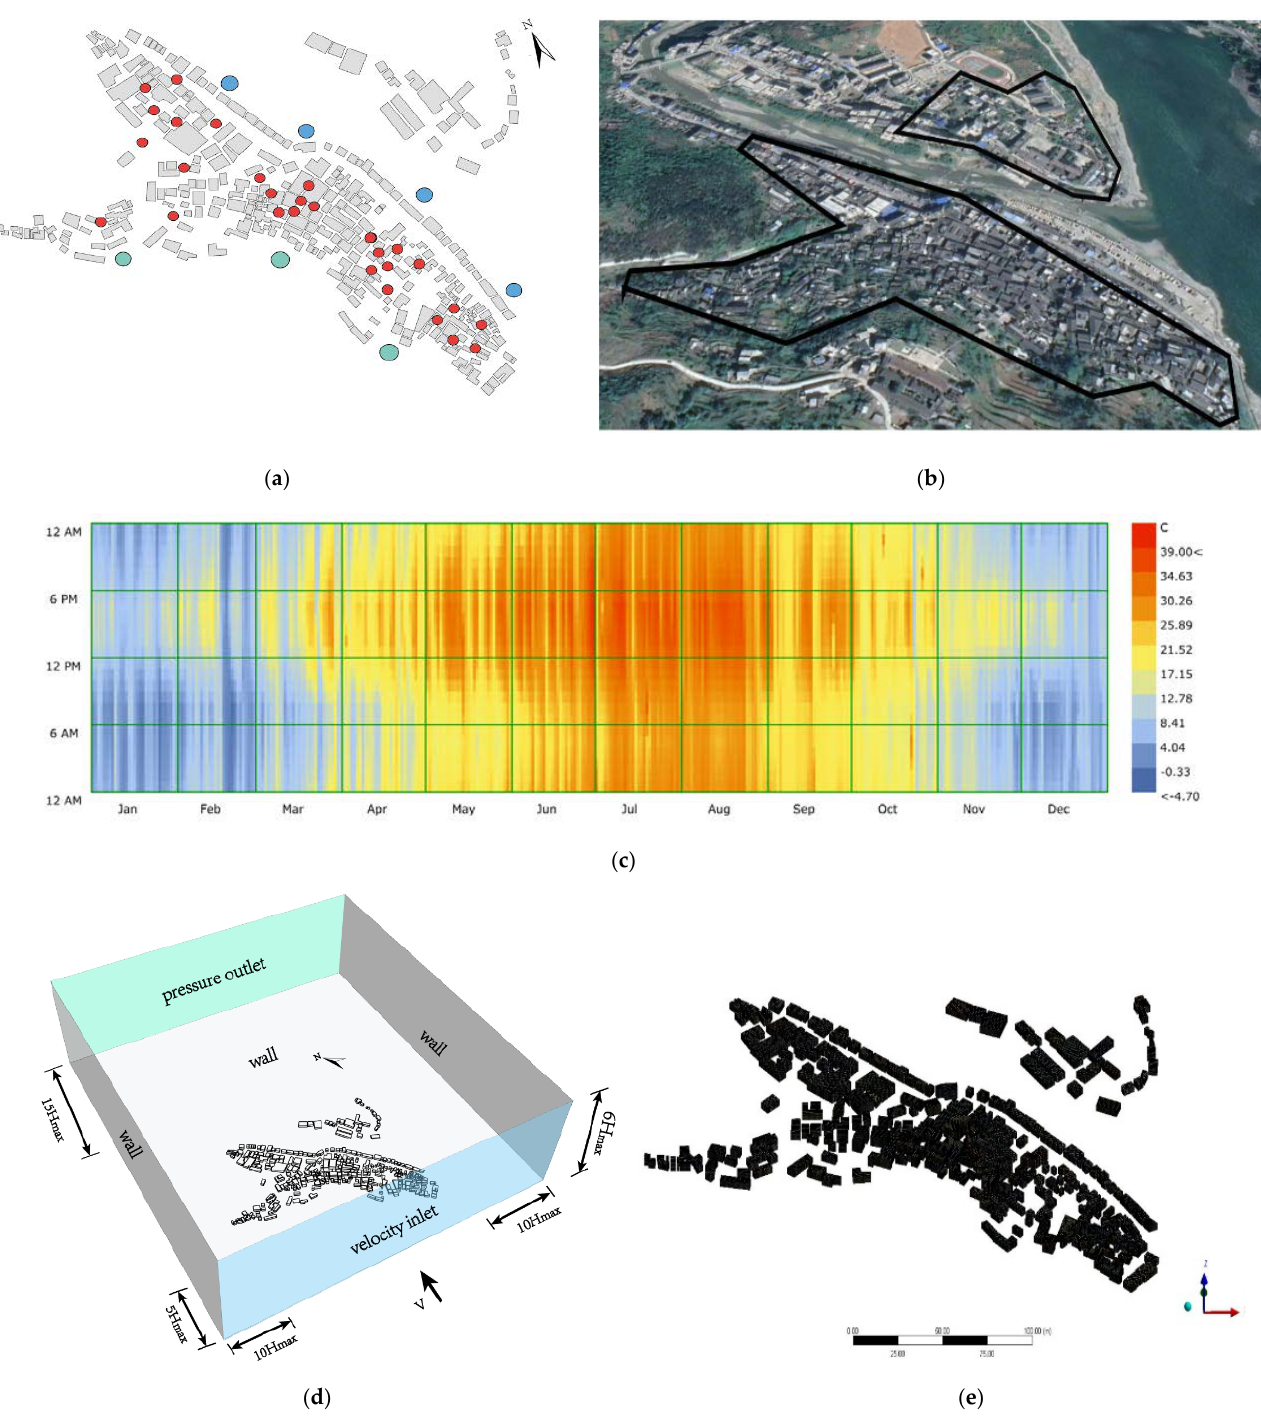
Figure 3. ( a ) Distribution of measuring points. ( b ) Scope of the study case. ( c ) Outdoor temperature distribution of study cases throughout the year. ( d ) Study case boundary conditions. ( e ) Meshing of study cases.